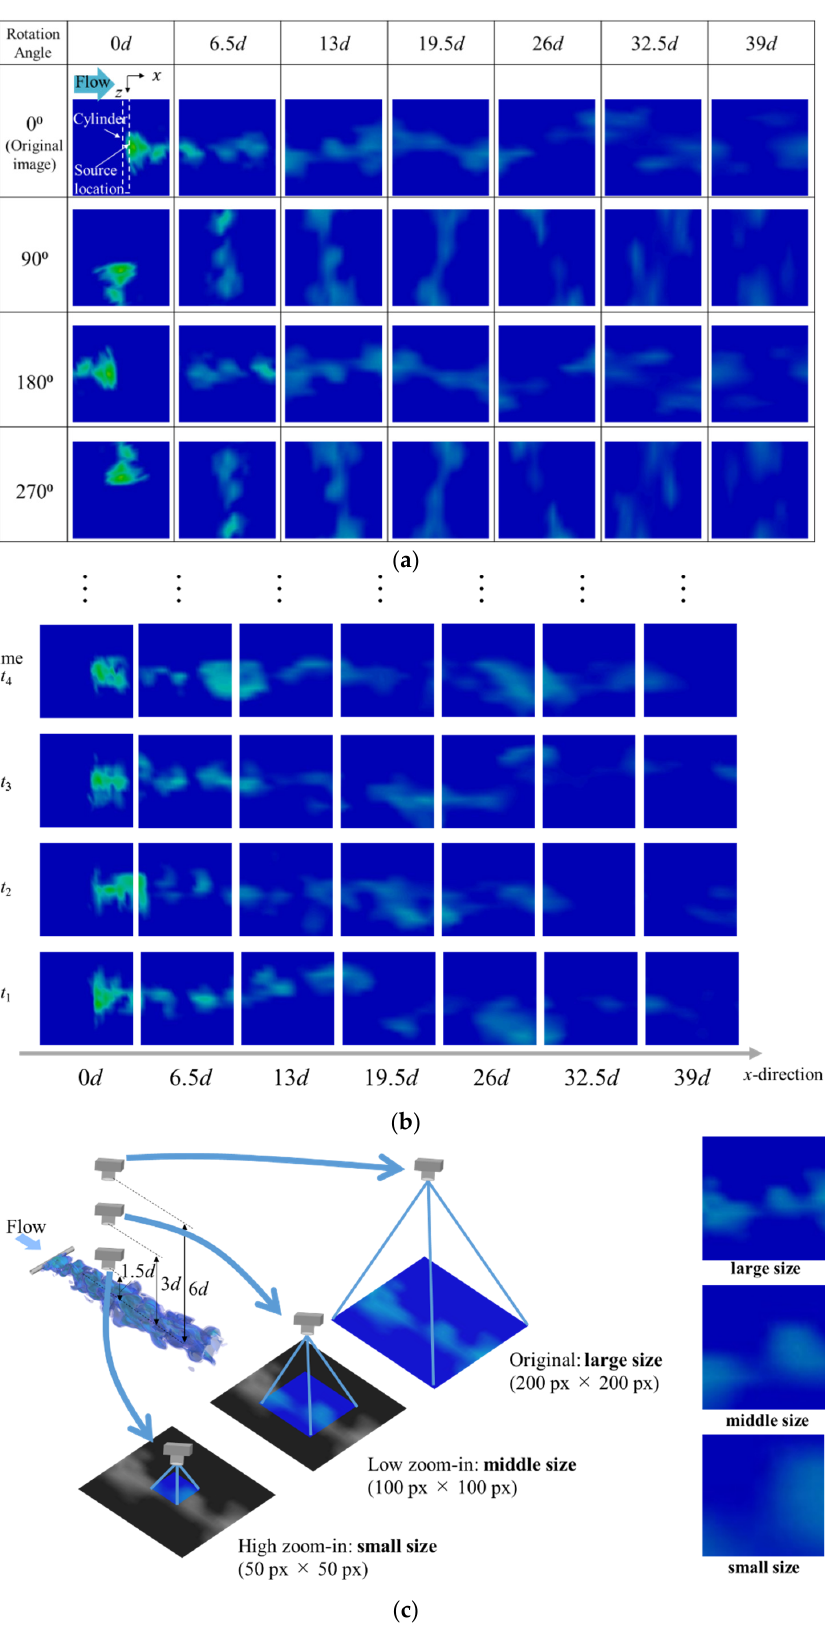
Figure 4. ( a ) Sample image for each class of machine learning and their rotated images; ( b ) sample images at different time instants; ( c ) conceptual diagram of each image